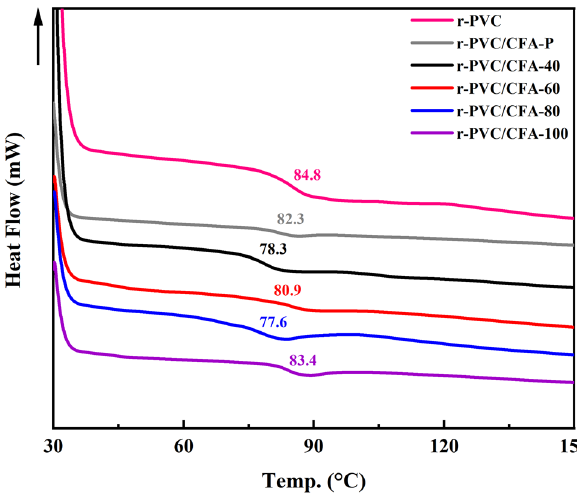
Figure 8: TGA curves for r - PVC, r - PVC/CFA - P, and r - PVC/CFA - X composites.